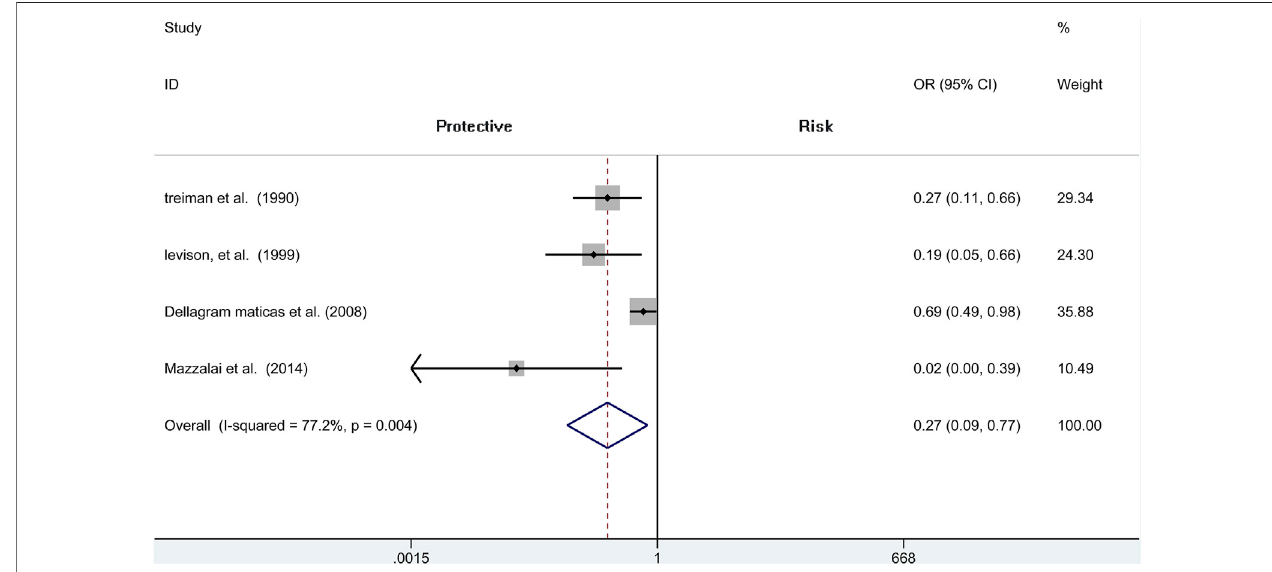
FIGURE 2 | Forest plot for meta-analysis of the incidence of wound hematoma.